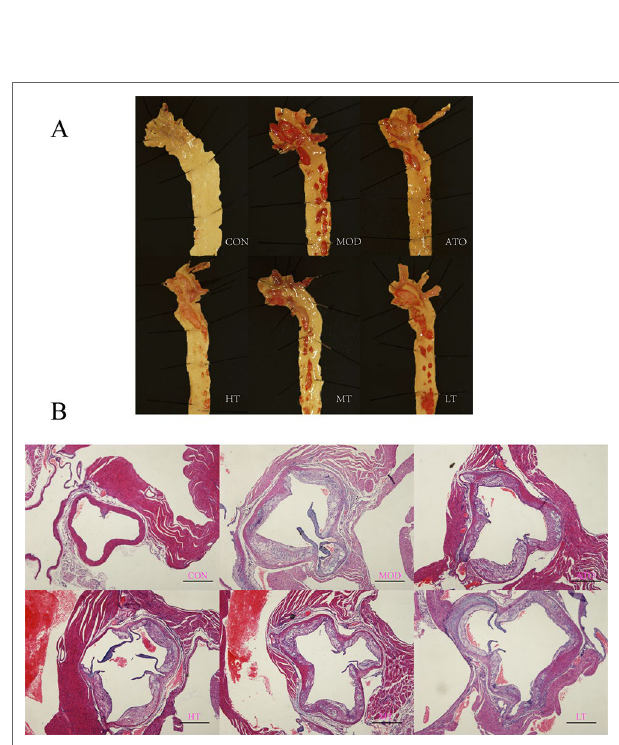
FIGURE 2 | Tan IIA and atorvastatin attenuated degree of AS lesion in ApoE −/− mice. (A) “En face” observation of aortic roots. (B) H&E staining of aortic roots. A: CON, B: MOD, C: ATO, D: HT, E: MT, F: LT (bar = 500